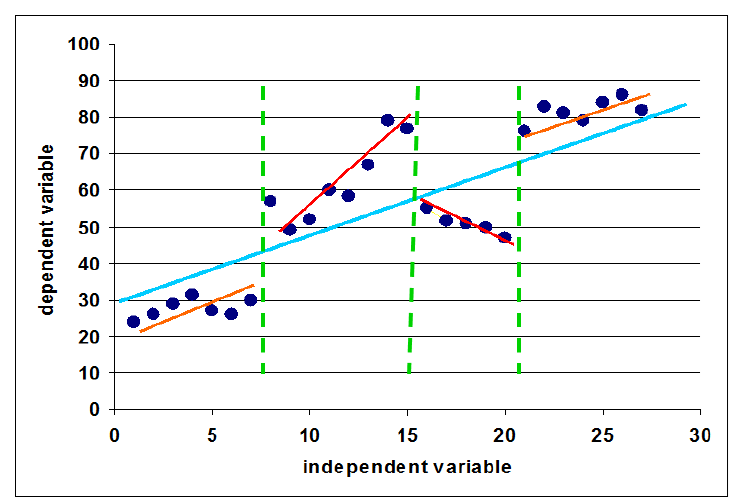
Figure 2. Conceptual demonstration of how a regression tree produces split rules fitting local models for final classification assignments. The red lines are produced for the clustered dots, and the green lines are classifying the different fits into different classes (the if conditions in RuleQuest [69] regression tree).